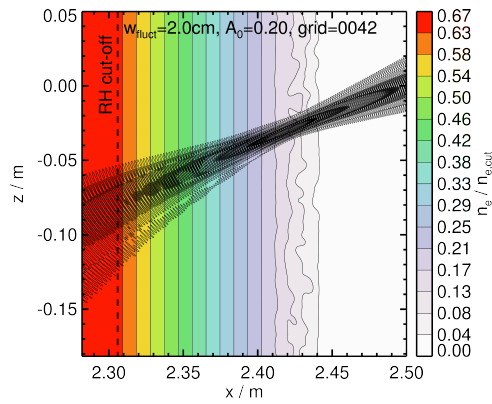
Figure 4. Contour plot of the electron plasma density (colored) and of the absolute value of the wave electric field as obtained from full-wave simulations intending to study cross-polarization scattering due to density fluctuations at low plasma